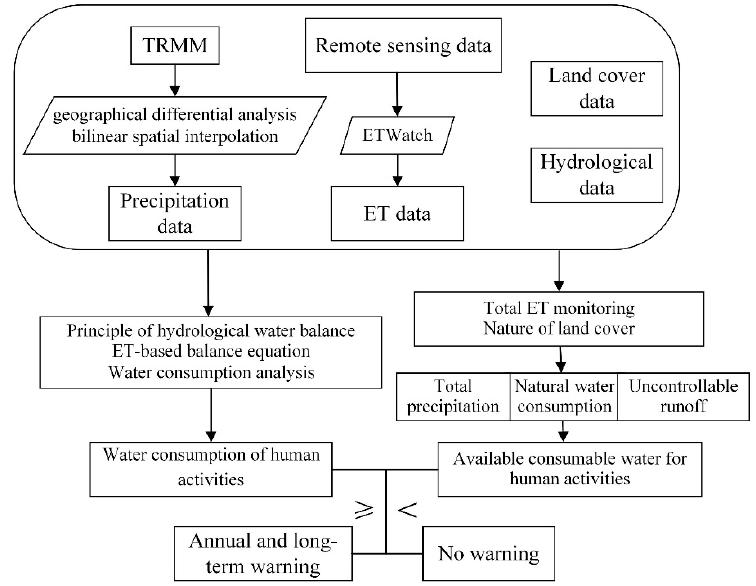
Figure 2. Flowchart of environmental flow regulation and warning.